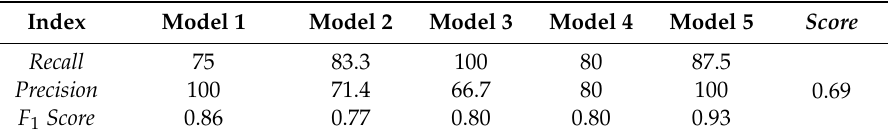
Table 9. The evaluation result of test set for CNN.